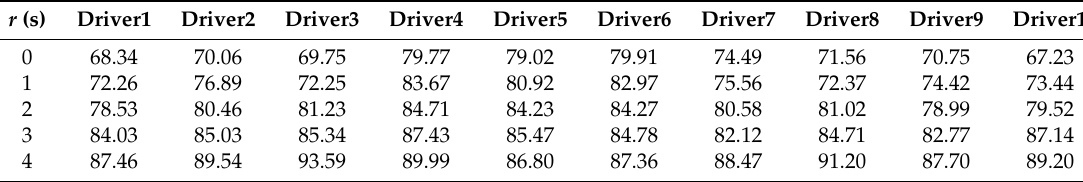
Table 8. Sensitivity (s) of testing data (O1).